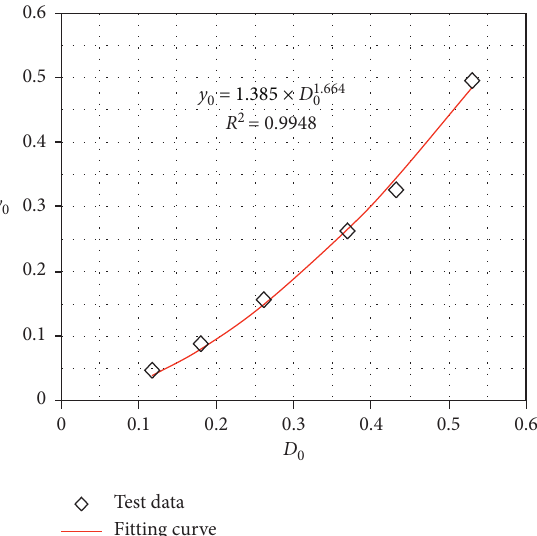
Figure 9: The relationship between y